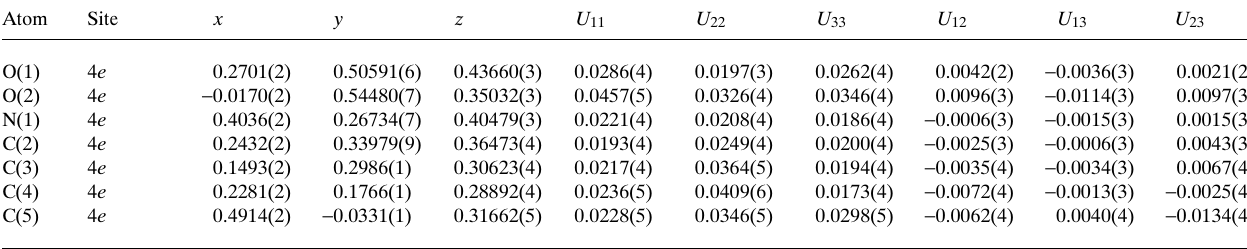
Table 3. Atomic coordinates and displacement parameters (in Å 2 )